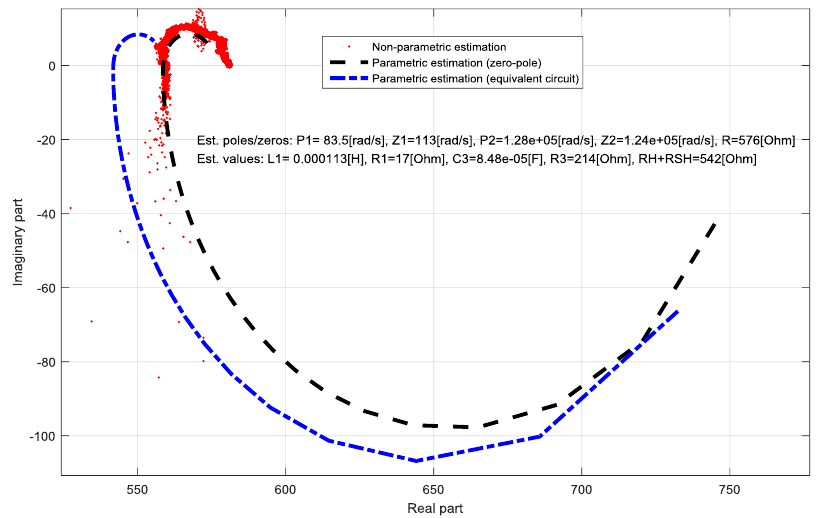
Figure 5. Comparison of the non-parametric and parametric TF identifications of a one-layer half-textile DSSC in Nyquist-diagram.